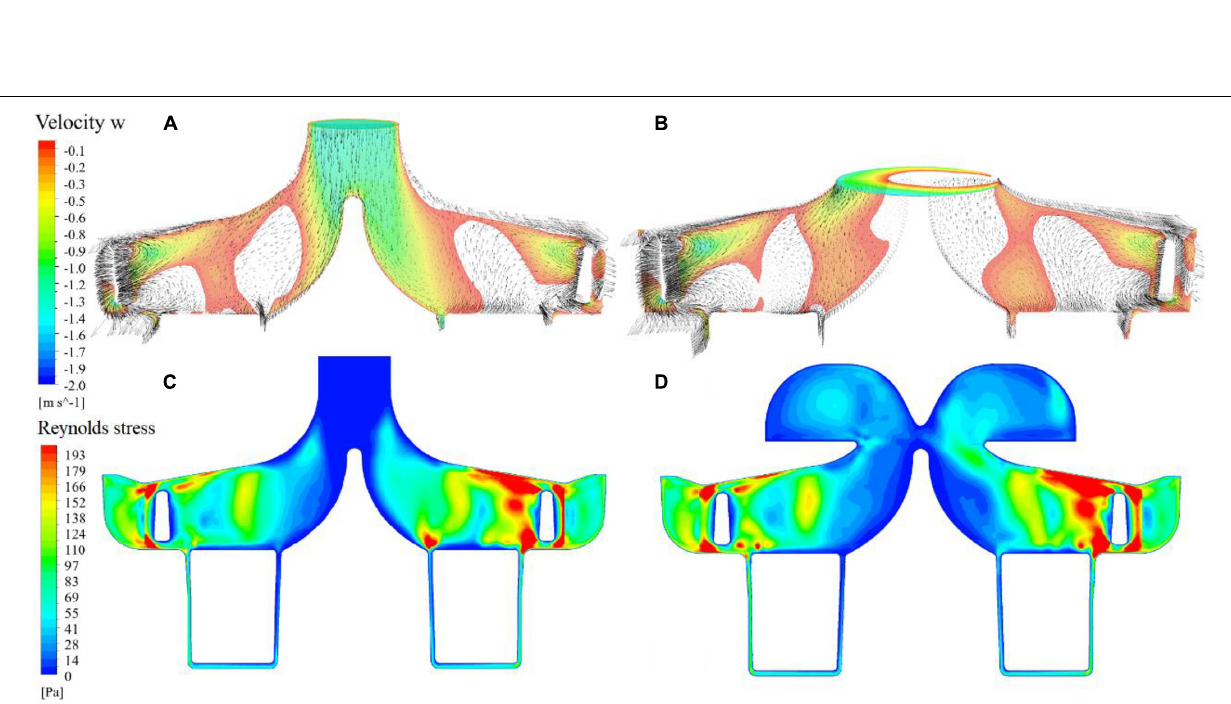
Frontiers in Physiology |